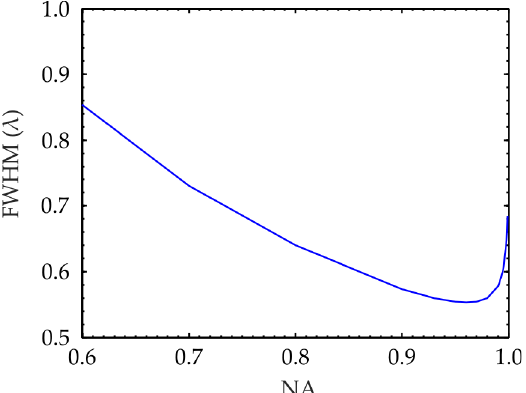
Figure 2. Dependence of the focal spot diameter on the full width at half maximum on the numerical aperture of the flat diffractive lens in the focusing of a plane wave with circular polarization.